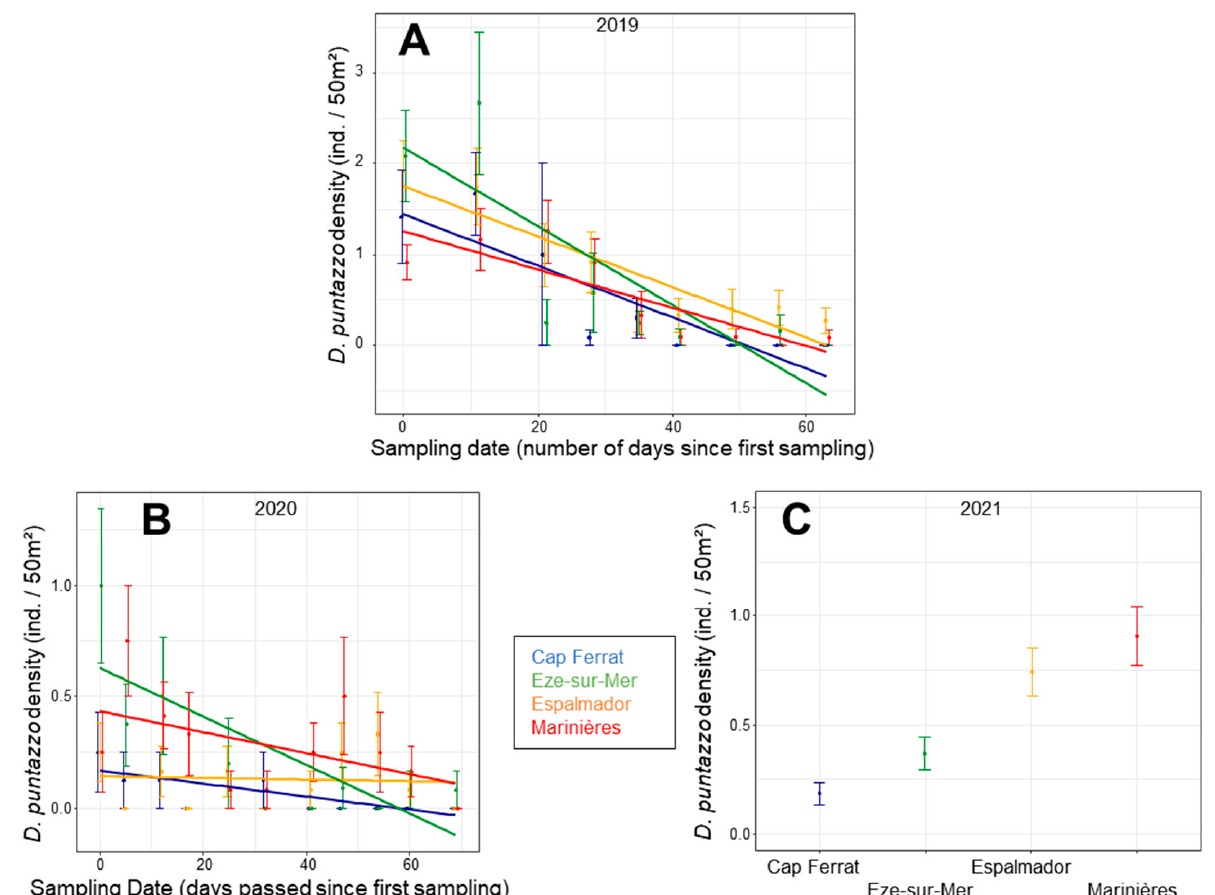
Figure 5. Mean ( ± SE) density values of D. puntazzo juveniles for the sampling days per each location in 2019 ( A ) and 2020 ( B ) and for each location in 2021 ( C ), according to the results of the glmm models. In ( A , B ), mean and SE are averaged across sampling days, transects and sites. In ( C ), they are averaged across sites.